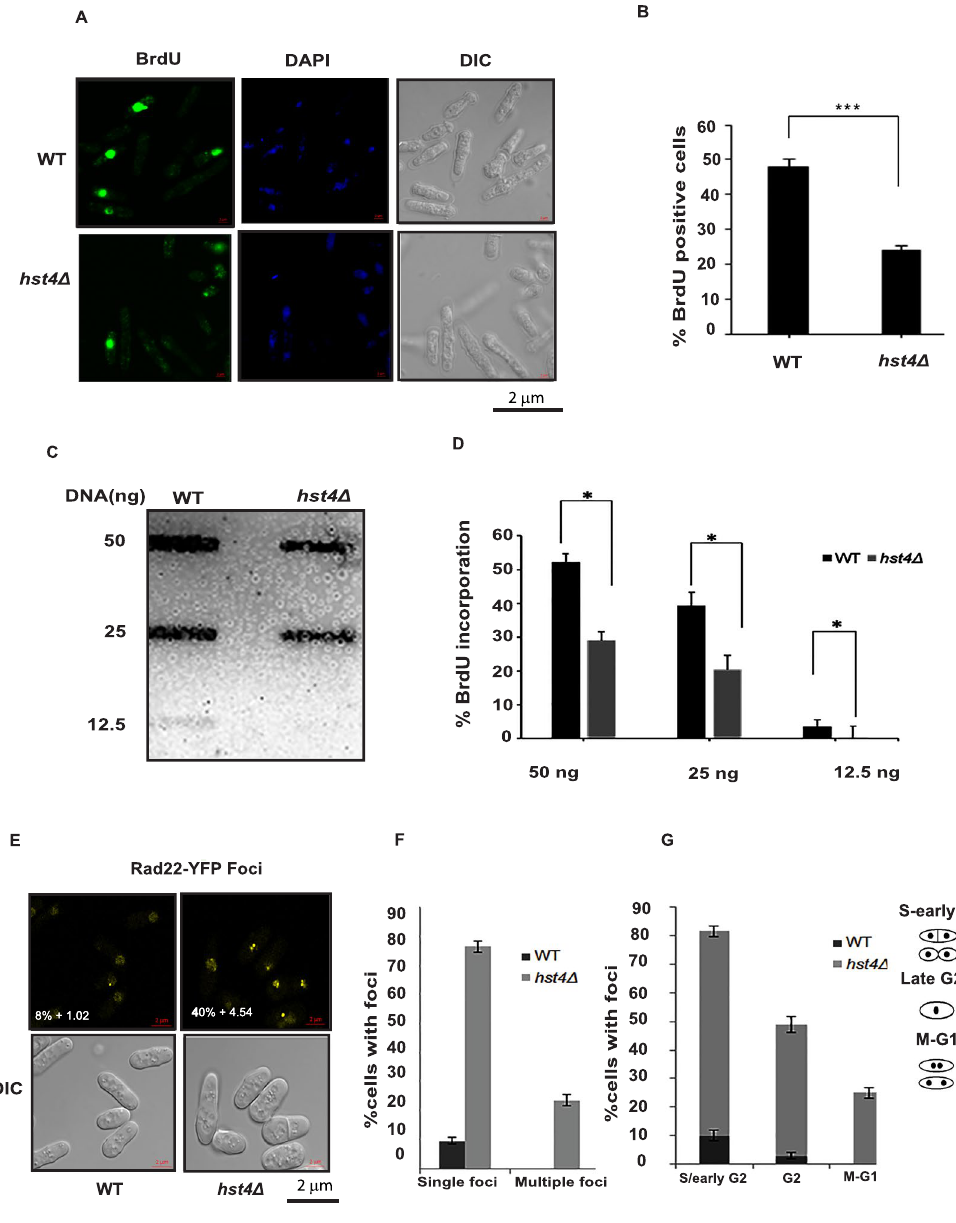
Figure 2. Deficiency of hst4 leads to replication defects. ( A ) Asynchronously growing wild type (FY4225) and hst4 Δ (DHP56) strains were grown in presence of BrdU (150 µ g/ml) for 30 minutes. Cells were fixed and stained with anti-BrdU antibody and visualized under fluorescent microscope. Bar = 2 µ m. ( B ) Quantification of the immunofluorescence data presented in Fig. 2A. The percentage of S-phase cells were determined by counting BrdU positive cells in wild-type and hst4 Δ mutants. Plotted are the mean values from three independent experiments. Student’s t test was used for statistical analysis. Error bars indicate mean ± S.D whereas three asterisks represent extremely significant difference, p -value < 0.001. ( C ) Slot blot showing BrdU incorporation in genomic DNA of wild type (FY4225) and hst4 Δ (DHP56) strains using anti-BrdU antibody. Equal amounts of genomic DNA was loaded for wild type and hst4 Δ mutants. ( D ) Quantification of BrdU incorporation of slot blot analysis. Average and standard deviations from samples of three independent experiments were plotted. Statistical significance p < 0.05 between wild-type and hst4 Δ strains is indicated with a single asterisk. ( E ) Rad22-YFP foci formation by life cell microscopy. Wild-type (ENY0670) and hst4 Δ mutant (DHP63) containing genomically tagged Rad22-YFP were grown to mid-log phase and percentage of nuclei with at least one Rad22 Foci is shown. Bar = 2 µ m. ( F ) Graph showing percent cells with single and multiple Rad22 foci in wild type and hst4 Δ mutants. Mean values from three independent experiments were used to calculate standard deviation. ( G ) Graph showing percent Rad22 foci according to different cell cycle stages of wild-type and hst4 Δ mutants. SD was calculated from three independent